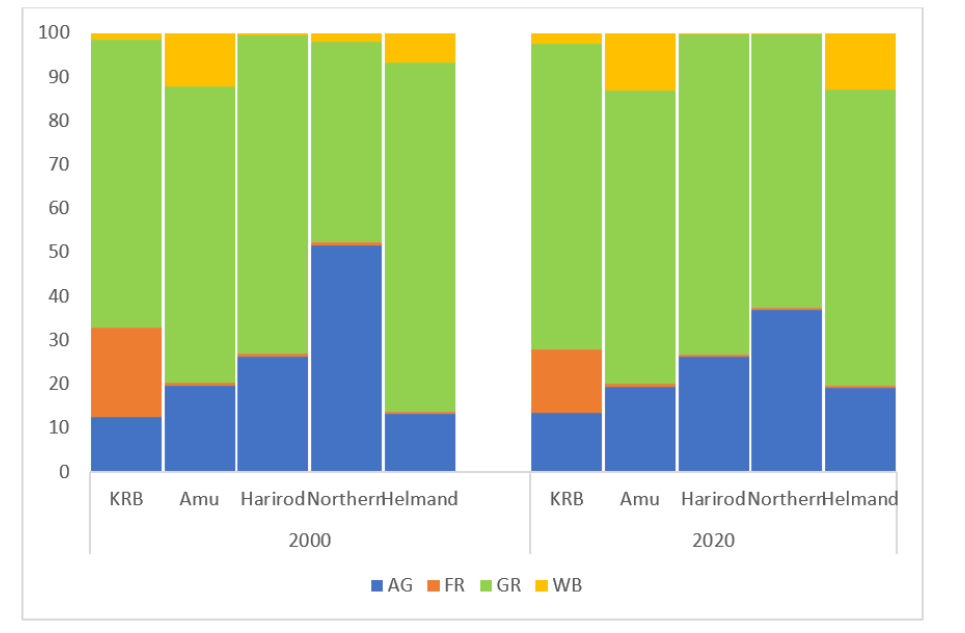
Figure 6. Regional contribution of various LULC in total ESV.